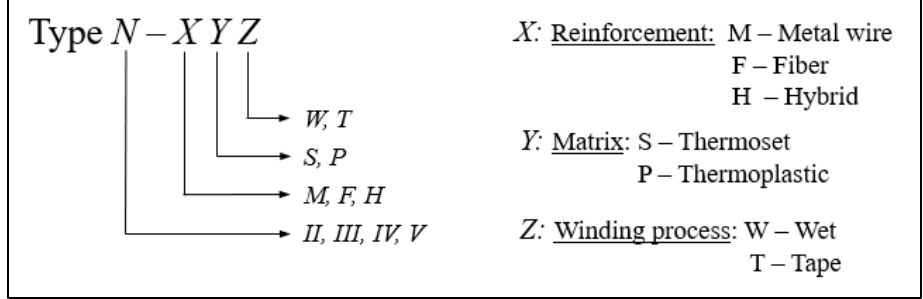
Figure 3. Classification for the sub-types of hydrogen tanks used in industrial applications. Table 5. Industrial winding configurations for hydrogen tanks; recent advances and future design trends.